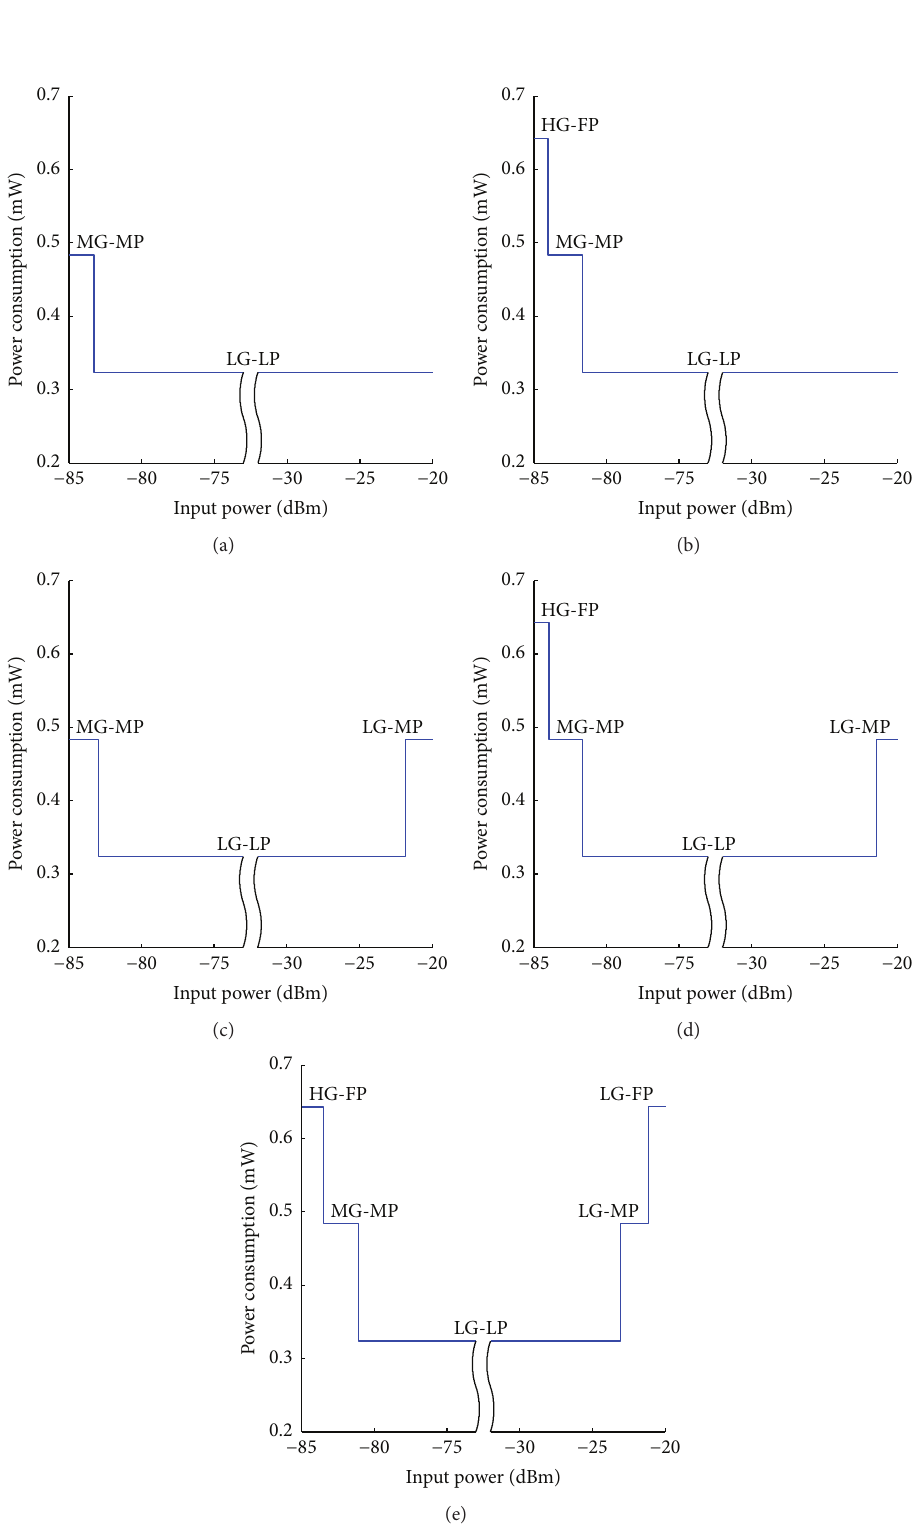
Figure 4: LNA power-consumption profile as a function of input-signal power, for different process-variations